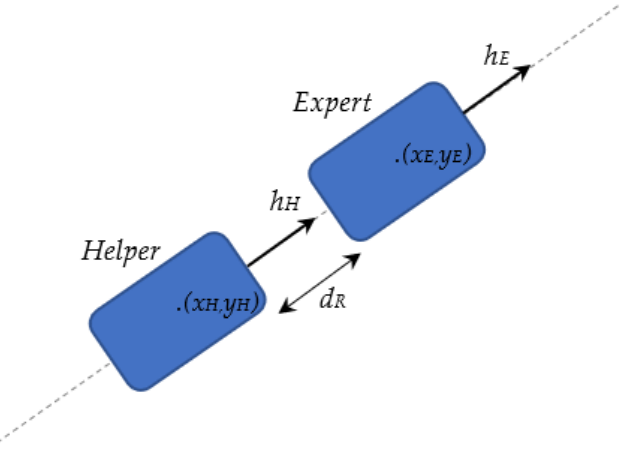
Figure 7. Initial positioning of the helper robot behind the expert robot.